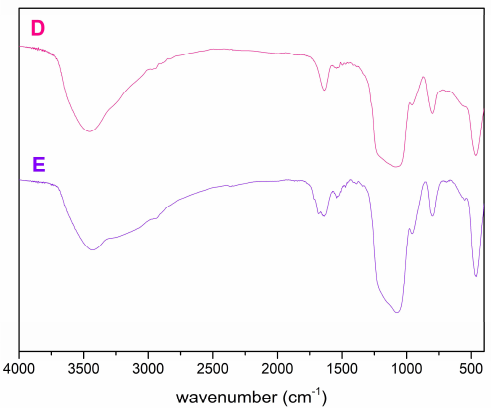
Figure 7. Infrared spectra of nanomaterials SBA-15 ( A ), 5-FU ( B ), 5-FU-SBA-15 ( C ), nSBA-15 ( D ), 5-FU-nSBA-15 ( E ), cSBA-15 ( F ) and 5-FU-cSBA-15 ( G